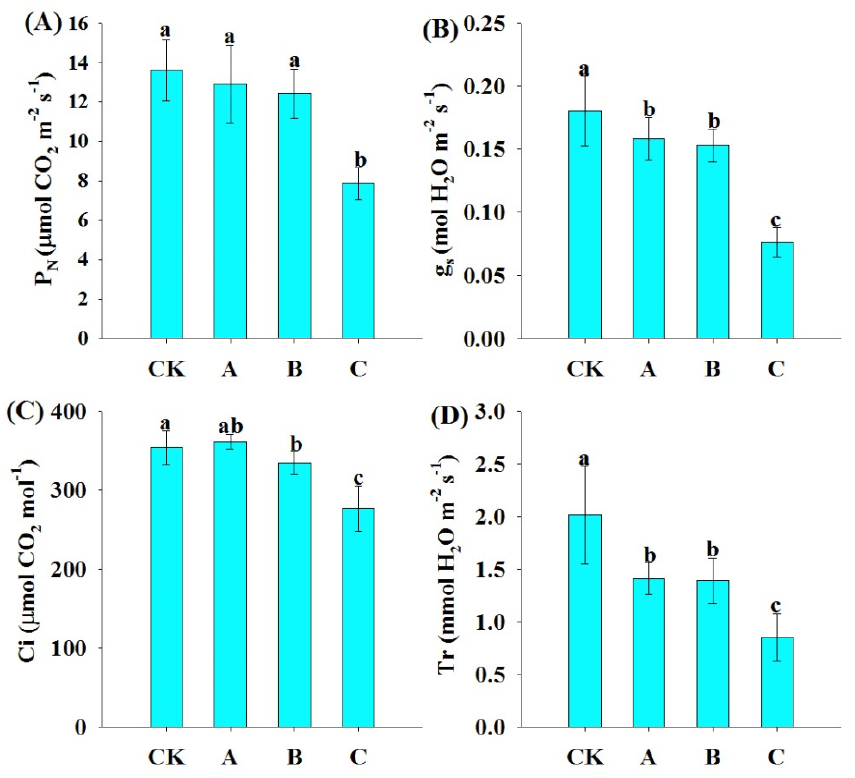
Figure 3. Effects of salinity and alkalinity stress on ( A ) net photosynthetic rate (P N ), ( B ) stomatal conductance (g s ), ( C ) internal CO 2 concentration (Ci), and ( D ) transpiration rate (Tr) of wheat seedlings. The bars represent the standard errors ( ± SE) of the four replicates. Different letters on the column represent significant difference among treatments ( p ≤ 0.05).